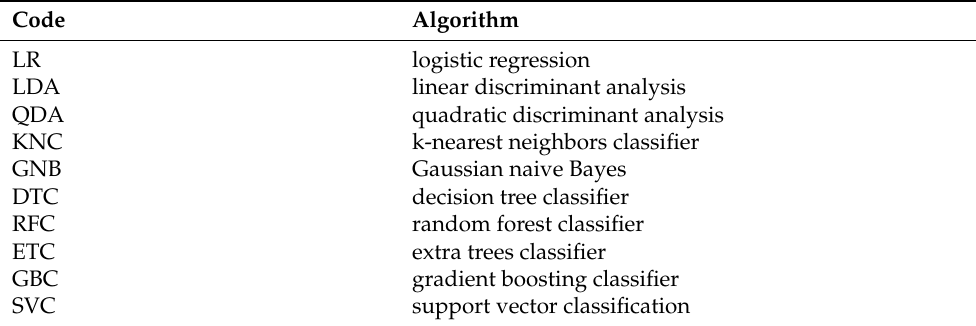
Table 3. List of the tested machine learning algorithms